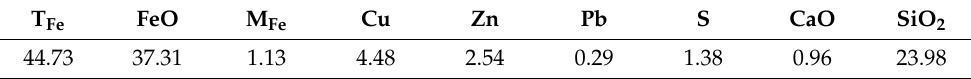
Table 1. Element analysis results of copper slag (wt. %).